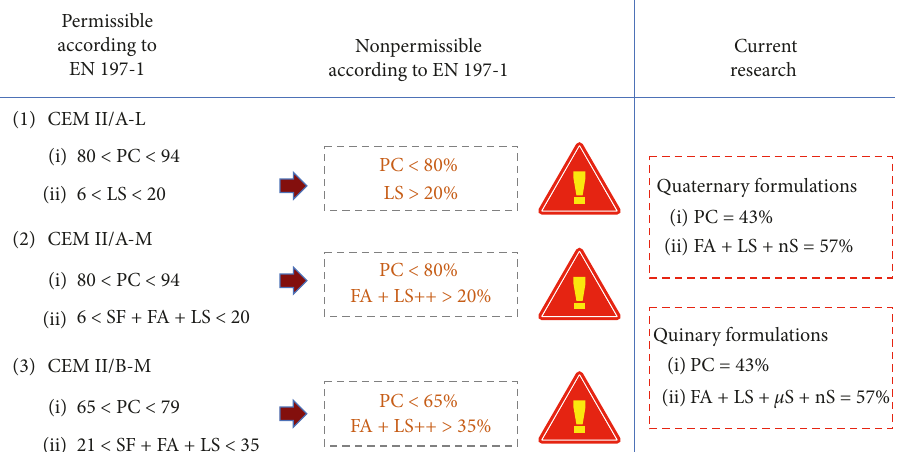
Figure 1: Permissible and nonpermissible limits of clinker substitution/SCM addition according to EN 197-1 and the challenge of the current